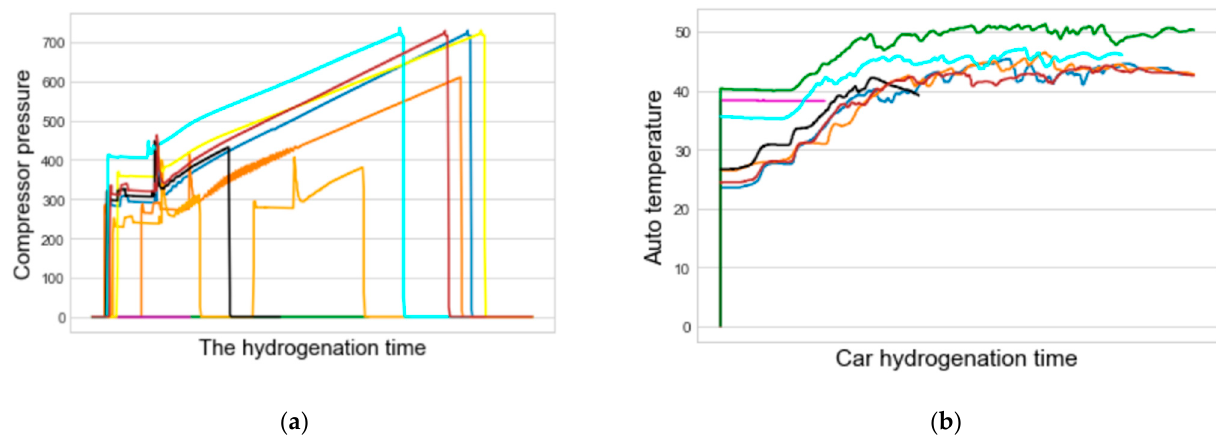
Figure 2. ( a ) The relationship between the normalized hydrogenation time and hydrogenation truck pressure. ( b ) The relationship between the normalized hydrogenation time and hydrogenation car temperature.